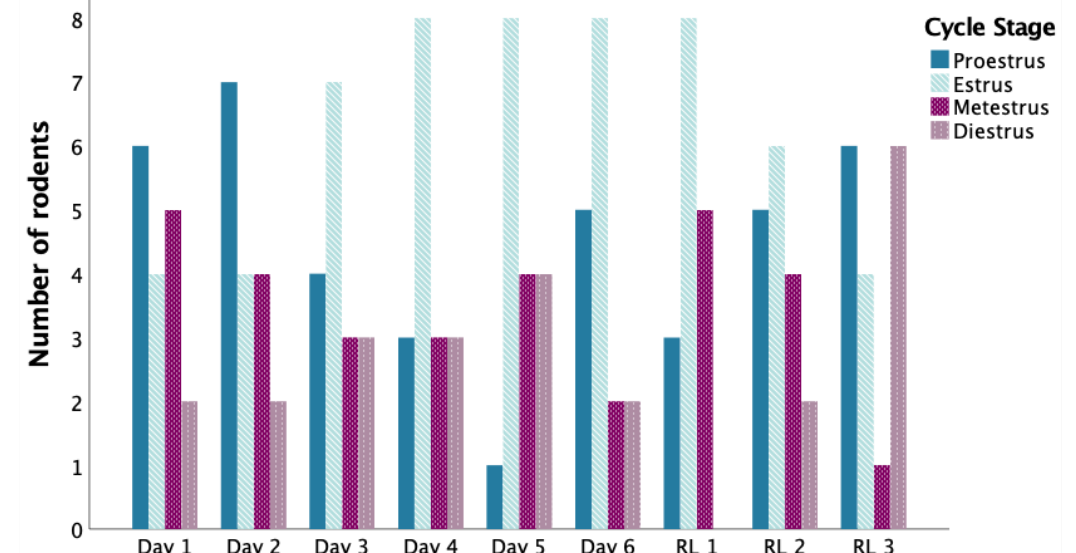
Figure 5. Estrous Cycle Stages. Vaginal cytological evaluation analysis was performed, and stages were visually identified for each day of the Barnes Maze Test, for adult rodents only ( n = 17).